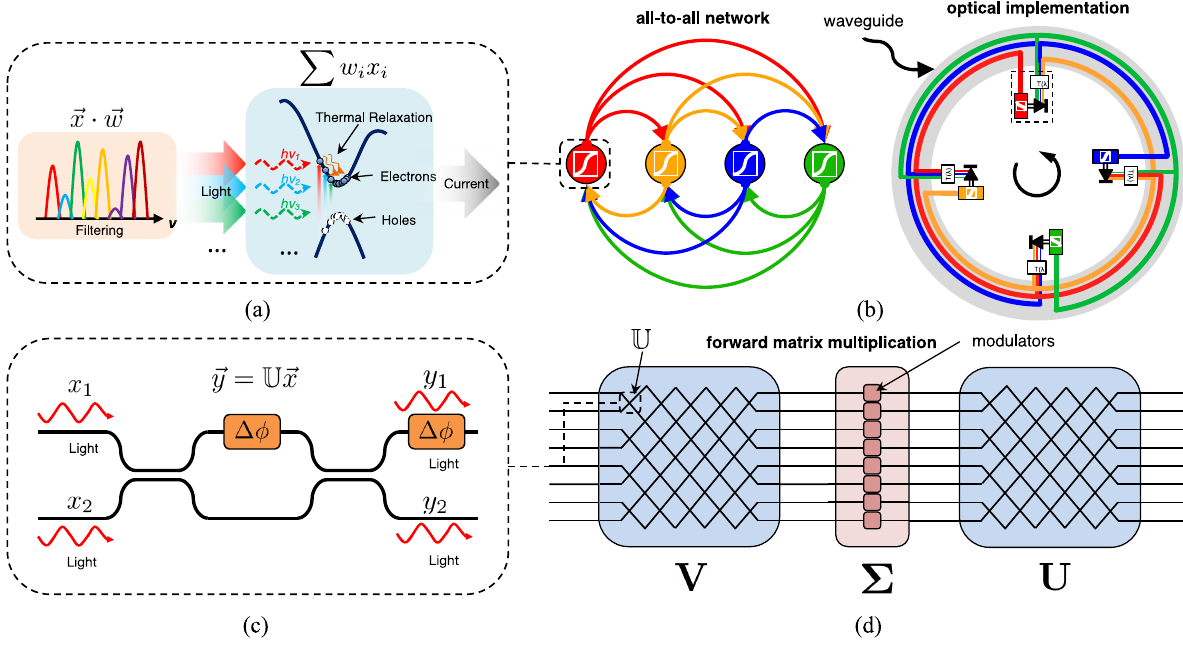
Figure 4: Schematics for incoherent (top) [93, 139] and coherent (bottom) [45] implementations of tunable photonic multiply-accumulate operations.(a)Incoherentapproachescandirectlyperformdotproductsonopticallymultiplexedsignals.However,theyrelyondetectorsand O/E conversion for summation. (b) The ability to multiplex allows for network fl exibility, which can enable larger-scale networks with minimal waveguide usage. (c) Coherent approaches can apply a unitary rotation to incoming lightwaves. This unit can perform a tunable 2 × 2 unitary rotation denoted by U . (d) Example of scaling the system to perform a matrix operation in a feedforward topology, using a U unit at each crossing together with singular value decomposition. Reproduced from Ref. [143].